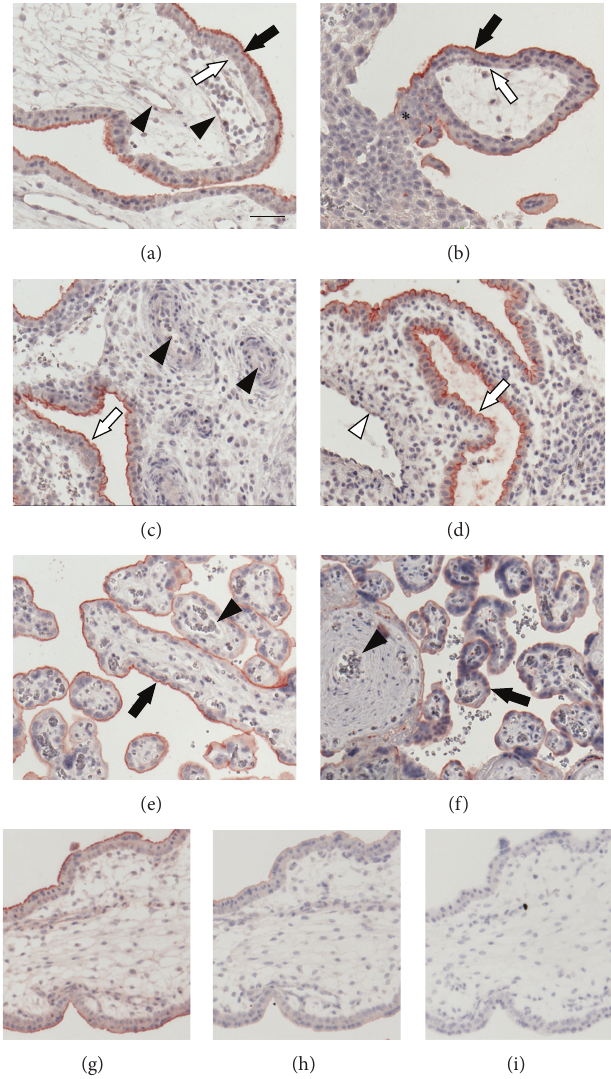
Figure 1: Immunohistochemical localization of fractalkine in human placenta. In first trimester placental villi fractalkine was only detected at the apical microvillous plasma membrane of the syncytiotrophoblast ((a) and (b), black arrow), but not in the fetal endothelium ((a), arrowheads), villous cytotrophoblasts ((a) and (b), open arrows), and extravillous trophoblasts in cell columns ((b), asterisk). In first trimester decidua fractalkine was detected at the apical plasma membrane of uterine glandular epithelial cells ((c) and (d), open arrows), whereas spiral arteries ((c), arrowheads) and veins ((d), open arrowheads) did not show any staining. In term placenta fractalkine was detected at the apical plasma membrane of the syncytiotrophoblast ((e) and (f), black arrows). The fetal vascular endothelium of all villous types including terminal villi ((e), arrowheads) and stem villi ((f), arrowhead) did not express fractalkine. Specificity of the antibody was evaluated on serial first trimester placenta sections using an antibody preadsorption approach and negative control mouse IgG, respectively. While incubation with the antibody alone confirmed the above described staining pattern (g), preadsorption of the antibody with recombinant fractalkine almost completely abolished staining (h). Incubation with negative control mouse IgG revealed no staining (i). Scale bar represents 50 𝜇